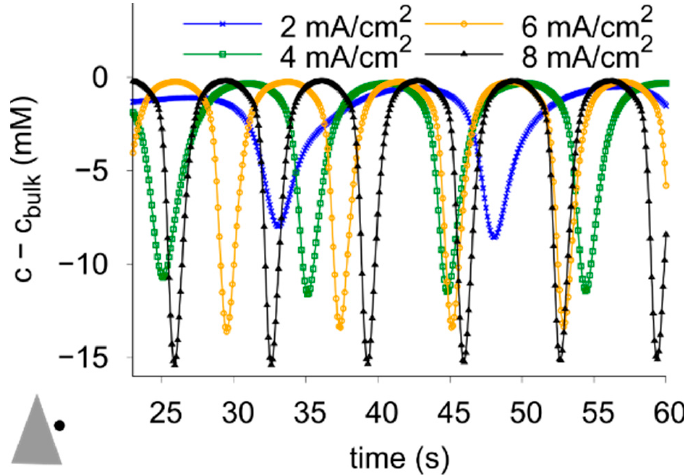
Figure 12. Numerical results on the variation in the bulk concentration for j cathode = 2, 4, 6, 8 mA/cm 2 at the monitoring point (0.77, 1.02) mm. The left side of the time axis is set at 23 s, after which steady-state oscillations have developed.